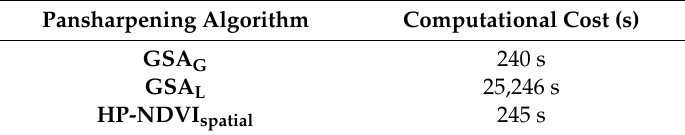
Table 4. Comparison of the computational cost of the proposed algorithm with those of GSA-based